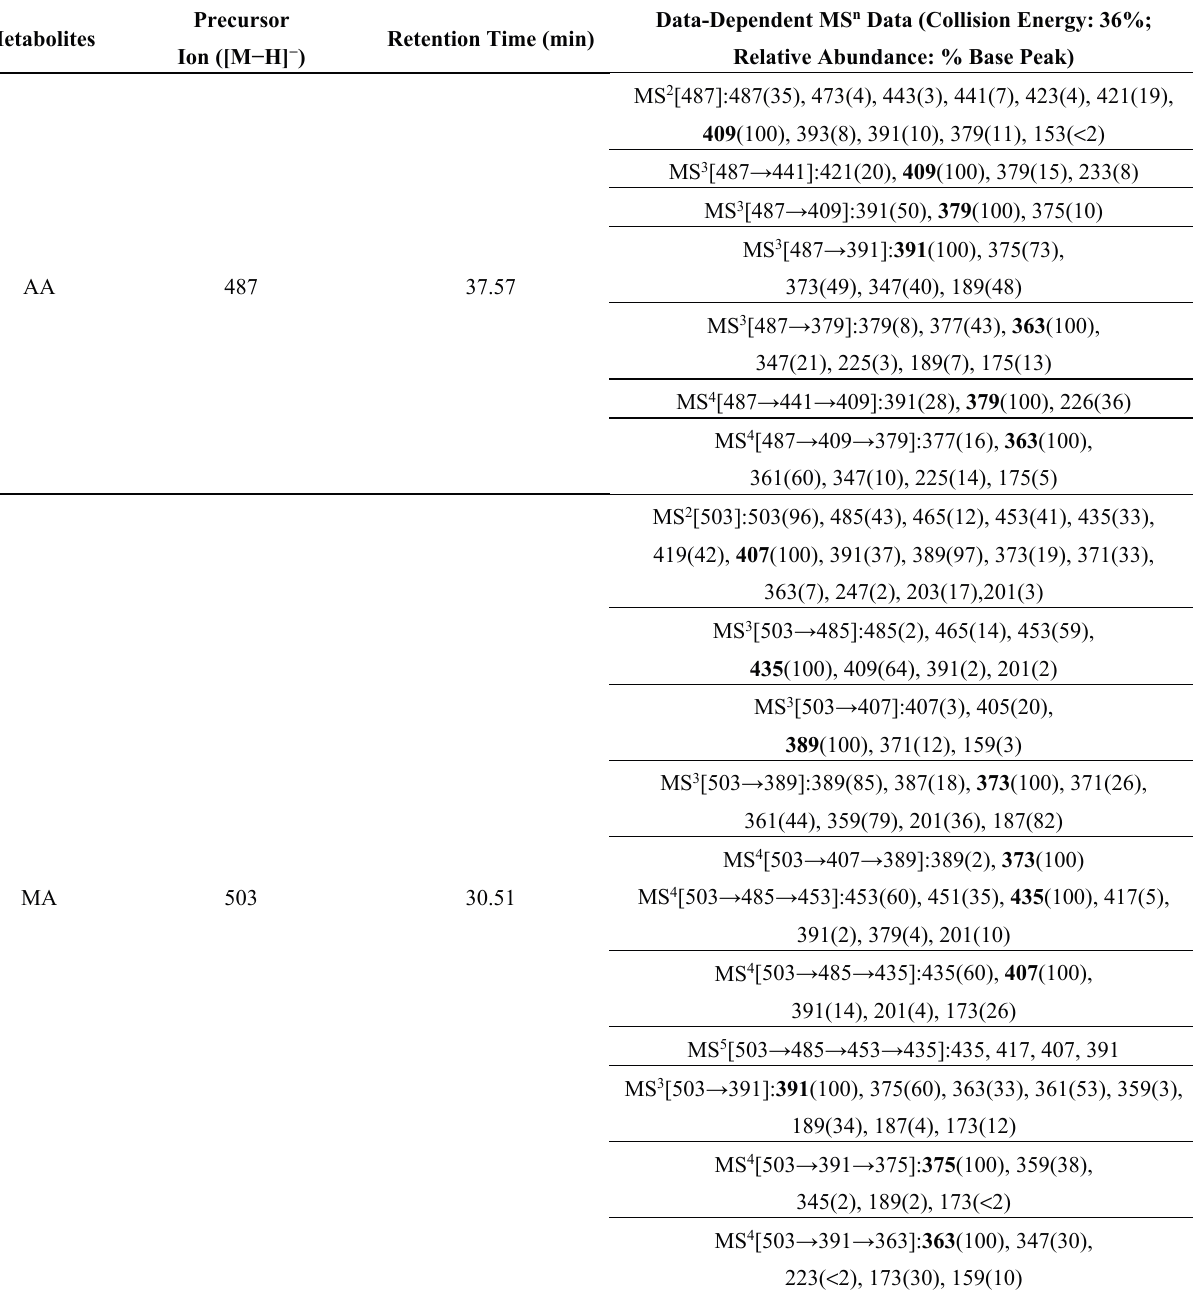
Table 1. Chromatographic retention times, mass spectrometric data of AA and